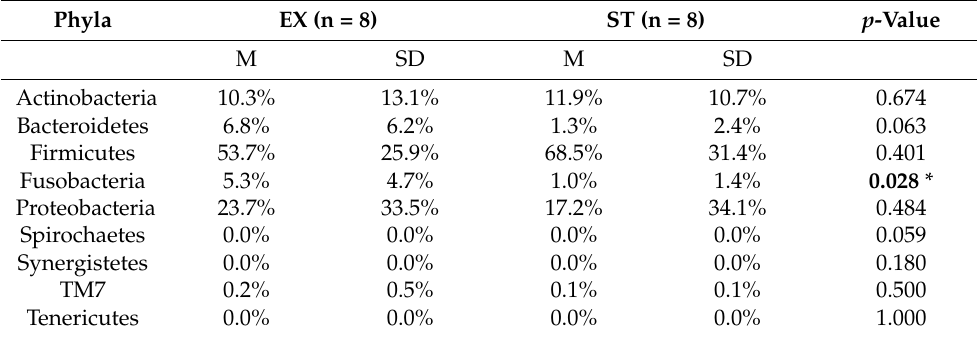
Table 5. The difference between the EX and ST samples in terms of the relative percentage of phyla detected in the